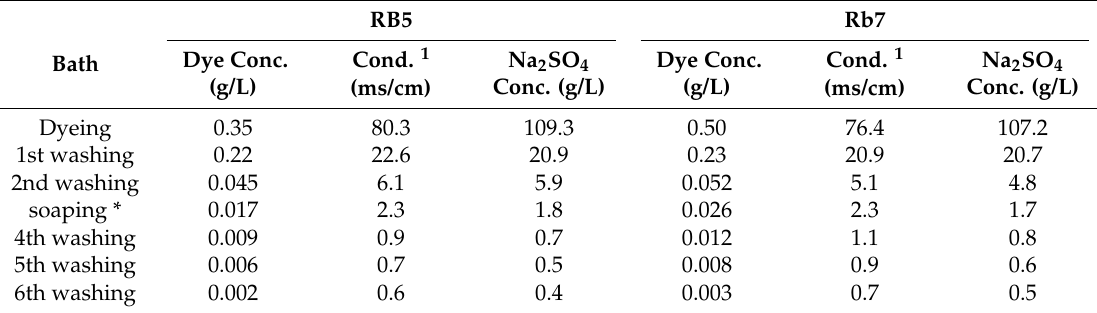
Table B1. Characterization of the dyeing and washing effluents obtained with the two dyes studied.